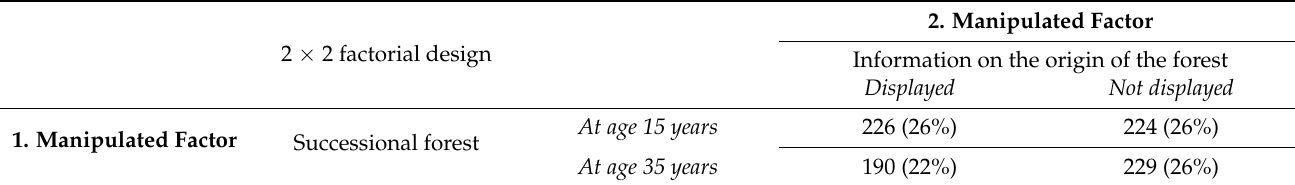
Table A1. Direct measure evaluation; 2 × 2 factorial between-subject design ( N = 869).